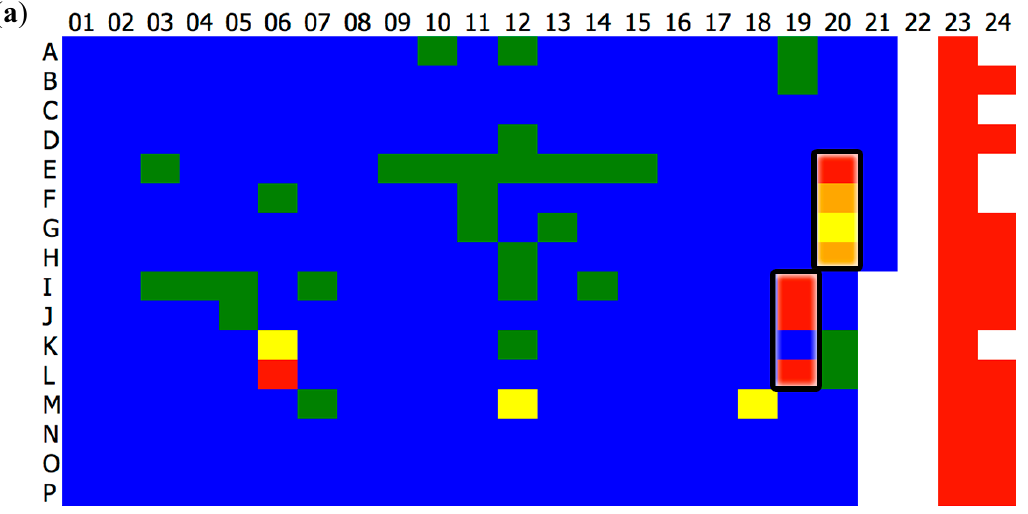
Figure 1. Differential scanning fluorometry (DSF) screen for compounds that alter the melting point of GRK5. ( a ) Representative heat map of a 384-well plate containing individual compounds from the deconvolution step of the screen. Colors correspond to >80% (red), 61%–80% (orange), 41%–60% (yellow), 21%–40% (green), <20% (blue) of a 3 standard deviation shift in the GRK5 melting point relative to the negative controls. Negative buffer-only controls occupy columns 1 and 2, non-protein containing controls (white) and positive ADP controls occupy columns 21 through 24. Individual compounds were evaluated 4 times in adjacent wells (running along columns). Compounds carried forward in the analysis were required to produce > 3 σ shift in the GRK5 melting point in at least 3 of the 4 wells. Staurosporine and Box5 are highlighted in wells 19 I–L and 20 E–G, respectively. ( b ) Chemical structures of the four hits identified in the